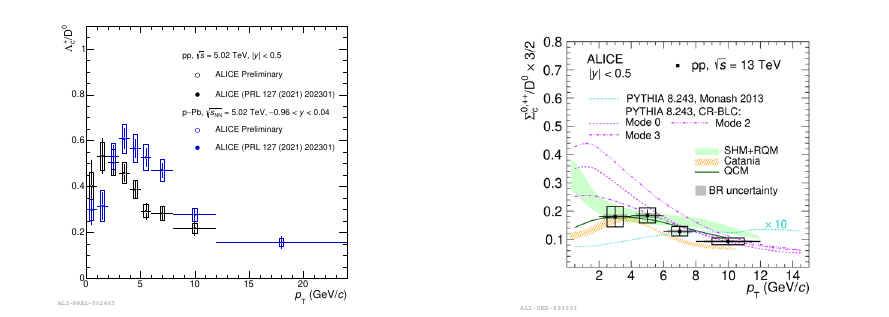
Figure 1. Left panel: Λ + c / D 0 as a function of p T in pp and p–Pb collisions at √ s = 5.02TeV . Right panel: Σ 0 , ++ c / D 0 ratio as a function of p T at √ s =